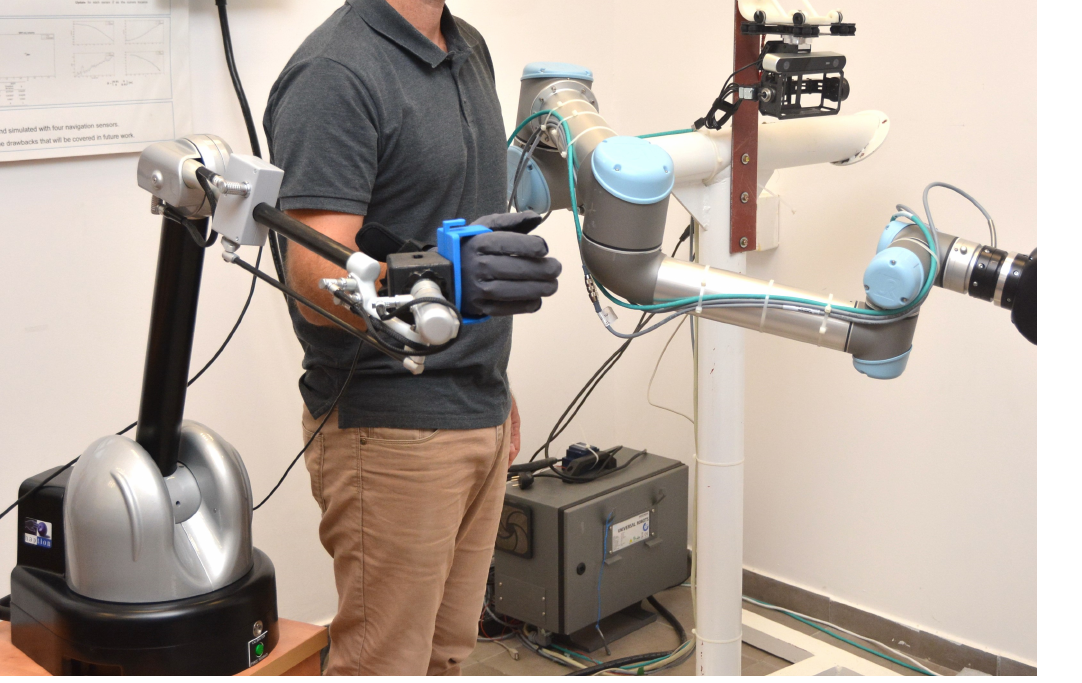
Figure 3. Tele-operation setup. Table 1. Lab equipment used in the